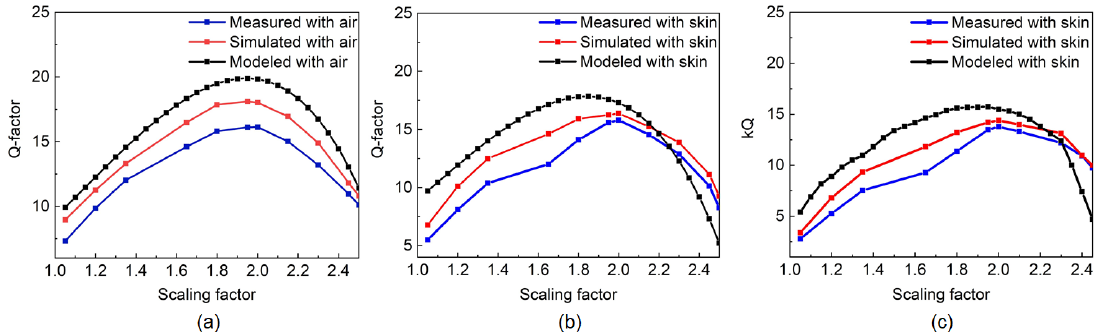
Figure 7. Modeled, simulated, and measured Q-factor with respect to the scaling factor, m ( a ) without skin contact, ( b ) with skin contact, and ( c ) kQ with respect to the scaling